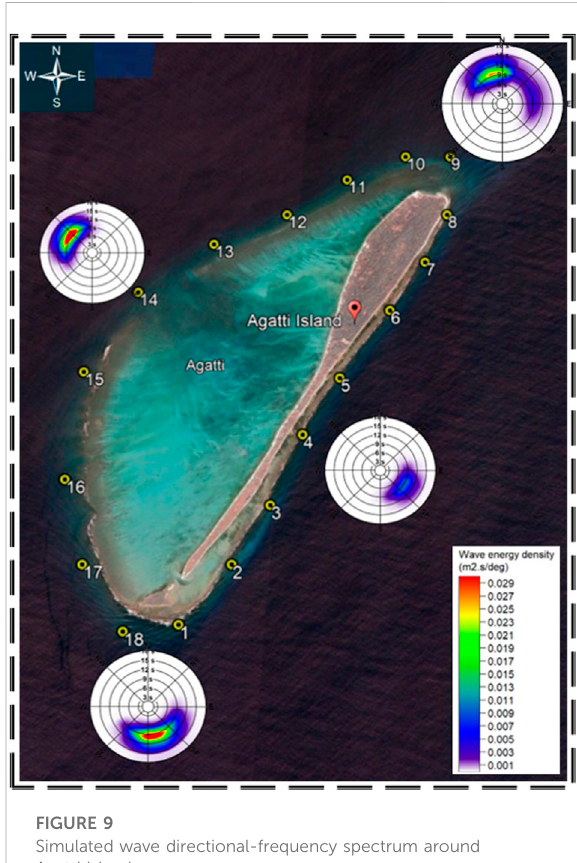
FIGURE 9 Simulated wave directional-frequency spectrum around Agatti island.